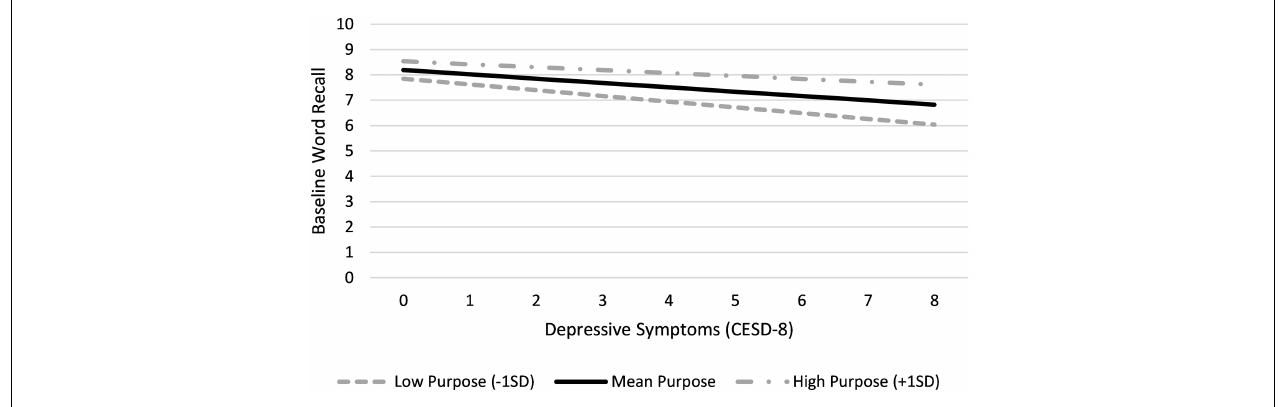
FIGURE 1 | Moderating effect of sense of purpose in life on associations between depressive symptoms and baseline word